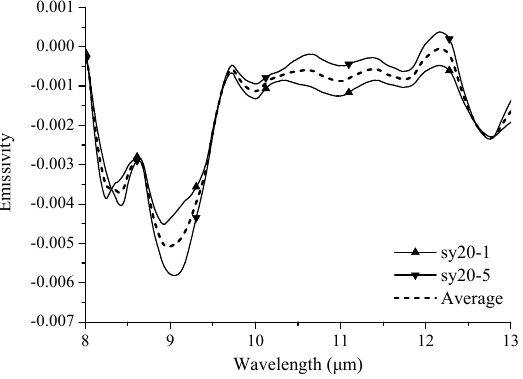
Figure 11. The emissivity variation spectrum of sandstone samples after and before bulging out- wards.